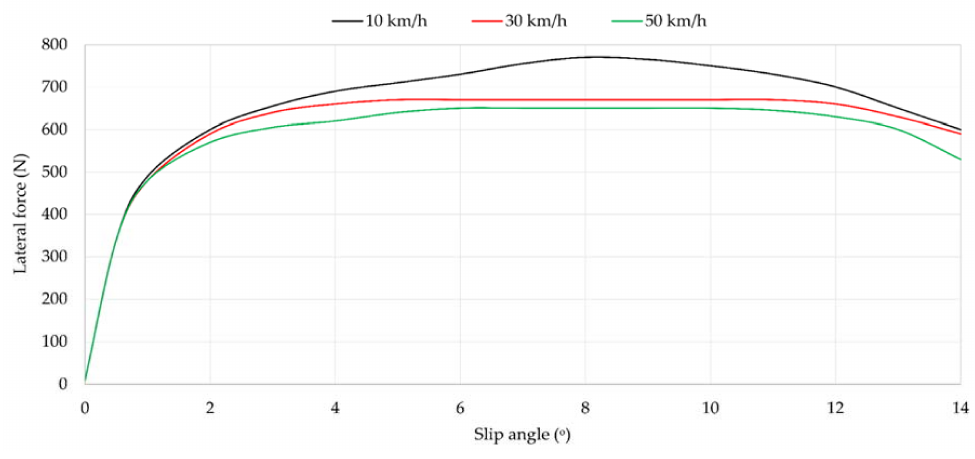
Figure 8. Influence of speed at 0.8 bar, 750 N. N: Newtons.